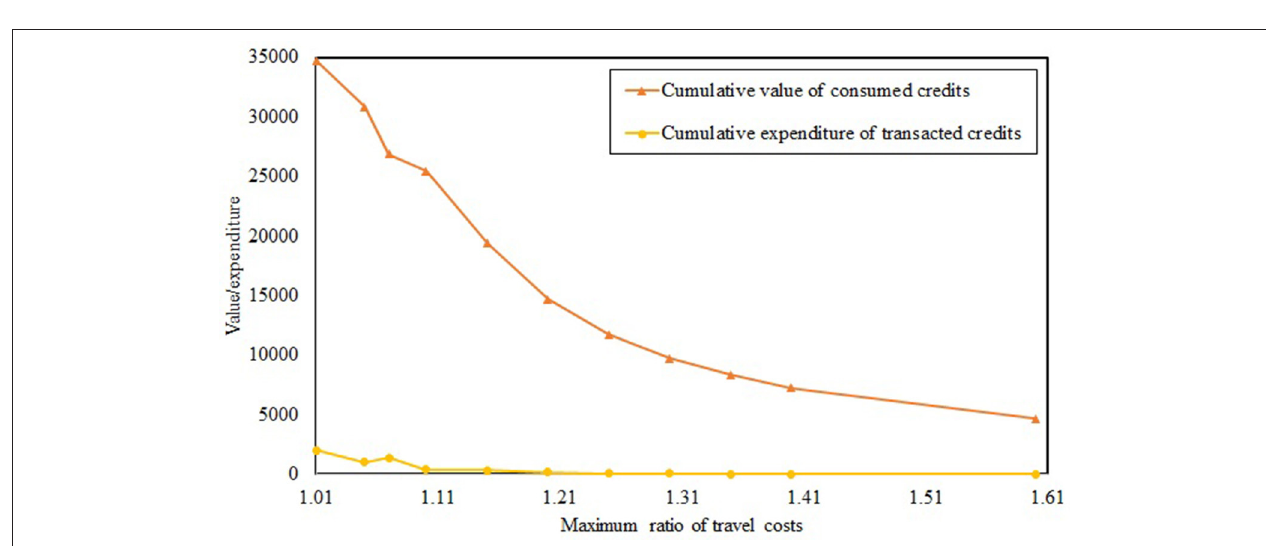
FIGURE 7 | Evolution of travel demand rate through the planning horizon under different maximum ratios of the travel cost.